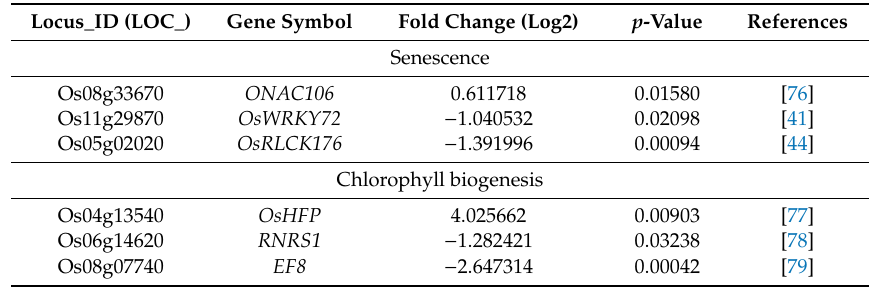
Table 2. Senescence-related and chlorophyll biogenesis genes di ff erentially expressed in ossrlk mutant by dark